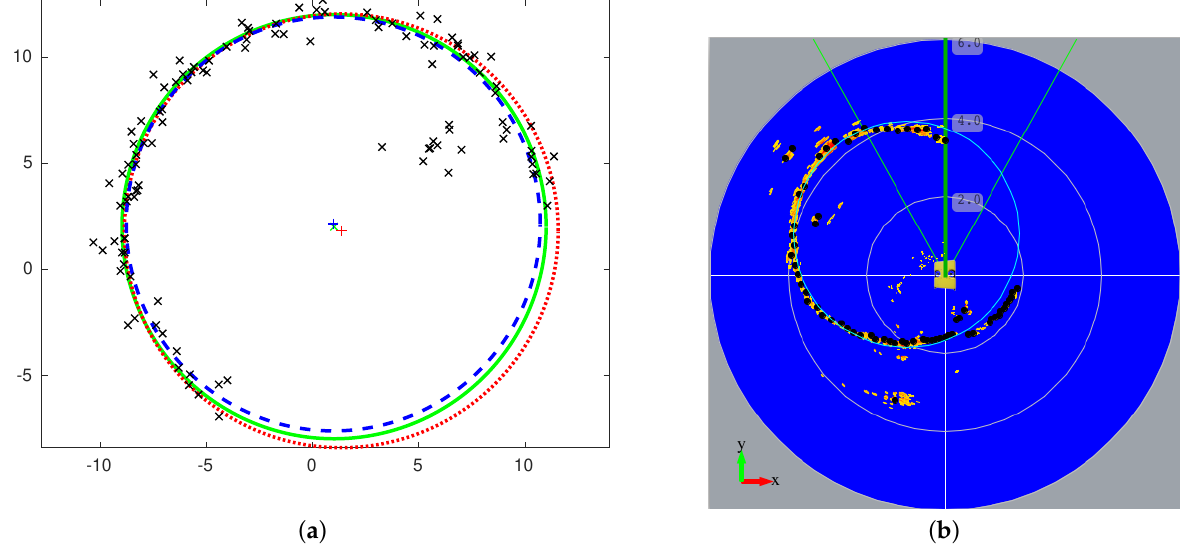
Figure 6. ( a ) Example of circle-fitting using noisy data, and ( b ) the fitted circumference using data received from the mechanical scanning sonar in a swimming pool with Algorithm